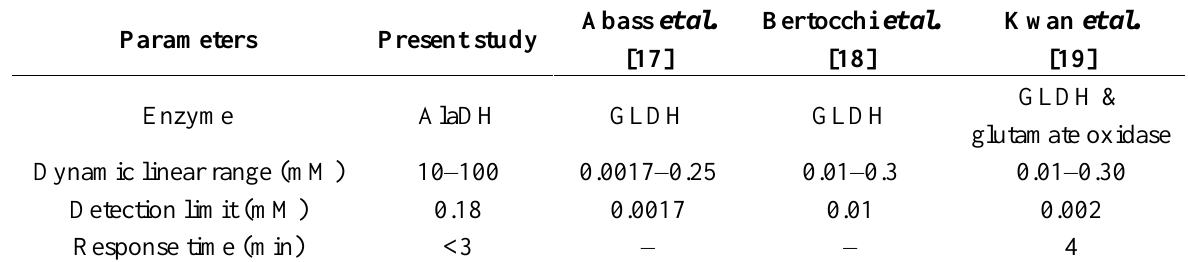
Table 4. The comparison between reagentless NH 4+ biosensor and reported amperometric NH 4+